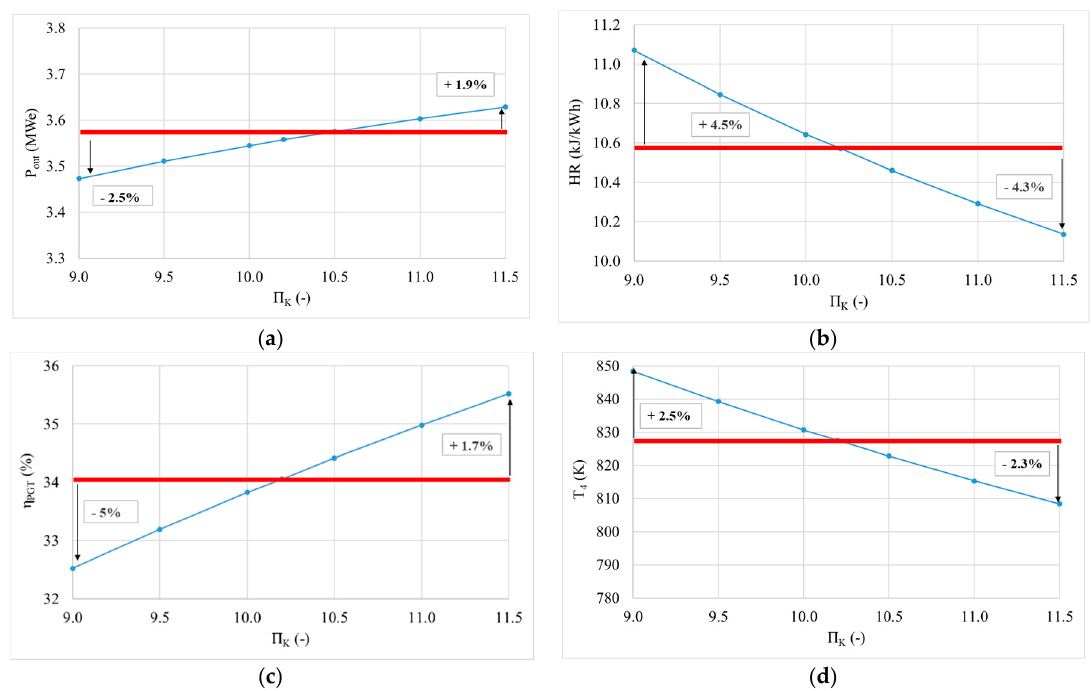
Figure 6. Change of gas turbine cycle outlet parameters in function of compressor pressure ratio ( a ) power change in function of compressor pressure ratio, ( b ) heat rate change in function of compressor pressure ratio, ( c ) gas turbine plant efficiency change in function of compressor pressure ratio and ( d ) change of temperature of the expanded products at the gas turbine outlet in function of compressor pressure ratio.